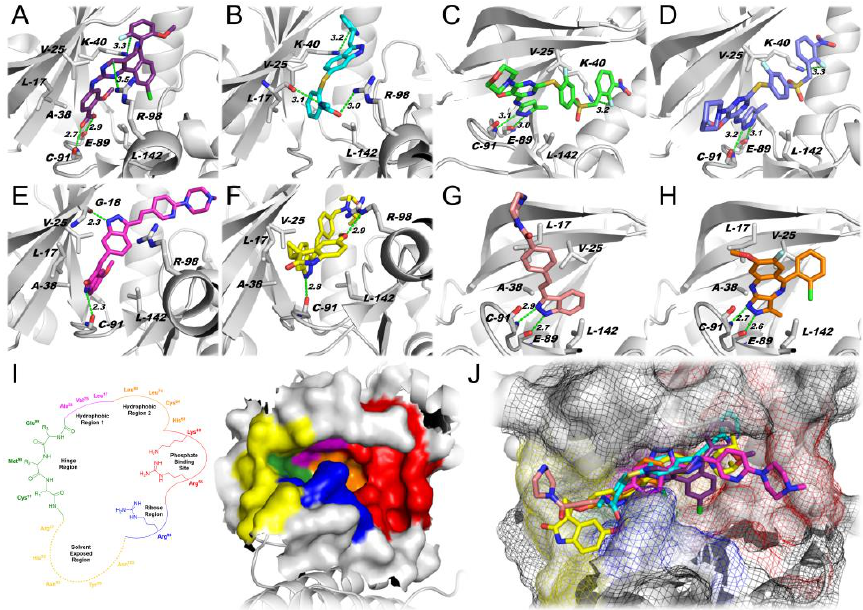
Figure 2. PLK4 in silico findings. ( A ) Docking pose of alisertib (carbons are depicted in purple). ( B ) Docking pose of axitinib (carbons are depicted in cyan). ( C ) Empirical complex of centrinone bound to PLK4 (Protein Data Bank (PDB) entry: 4YUR, carbons are depicted in green). ( D ) Docking pose of centrinone B (carbons are depicted in navy blue). ( E ) Docking pose of CFI-400437 (carbons are depicted in magenta). ( F ) Docking pose of CFI-400945 (carbons are depicted in yellow). ( G ) Docking pose of KW-2449 (carbons are depicted in light pink). ( H ) Docking pose of R1530 (carbons are depicted in orange). ( I ) Two-dimensional (2D, left) and three-dimensional (3D, right) schematic representation of the ATP-binding pocket of PLK4. ( J ) Superimposed pose of the inhibitors at the PLK4 binding cavity. Cartoon protein depicted in white. Carbons of PLK4 are depicted in white. Oxygen is depicted in red. Nitrogen is depicted in blue. In panels C and D, sulfur is depicted in yellow. In panels A, C, D, and H, fluorine is depicted in cyan. In panels A and H, chlorine is depicted in green. Hydrogen bonds are indicated as green dashed lines. Interatomic distances in angstroms (Å ). A: alanine; C: cysteine; E: glutamate; G: glycine; K: lysine; L: leucine; V: valine; R: arginine.